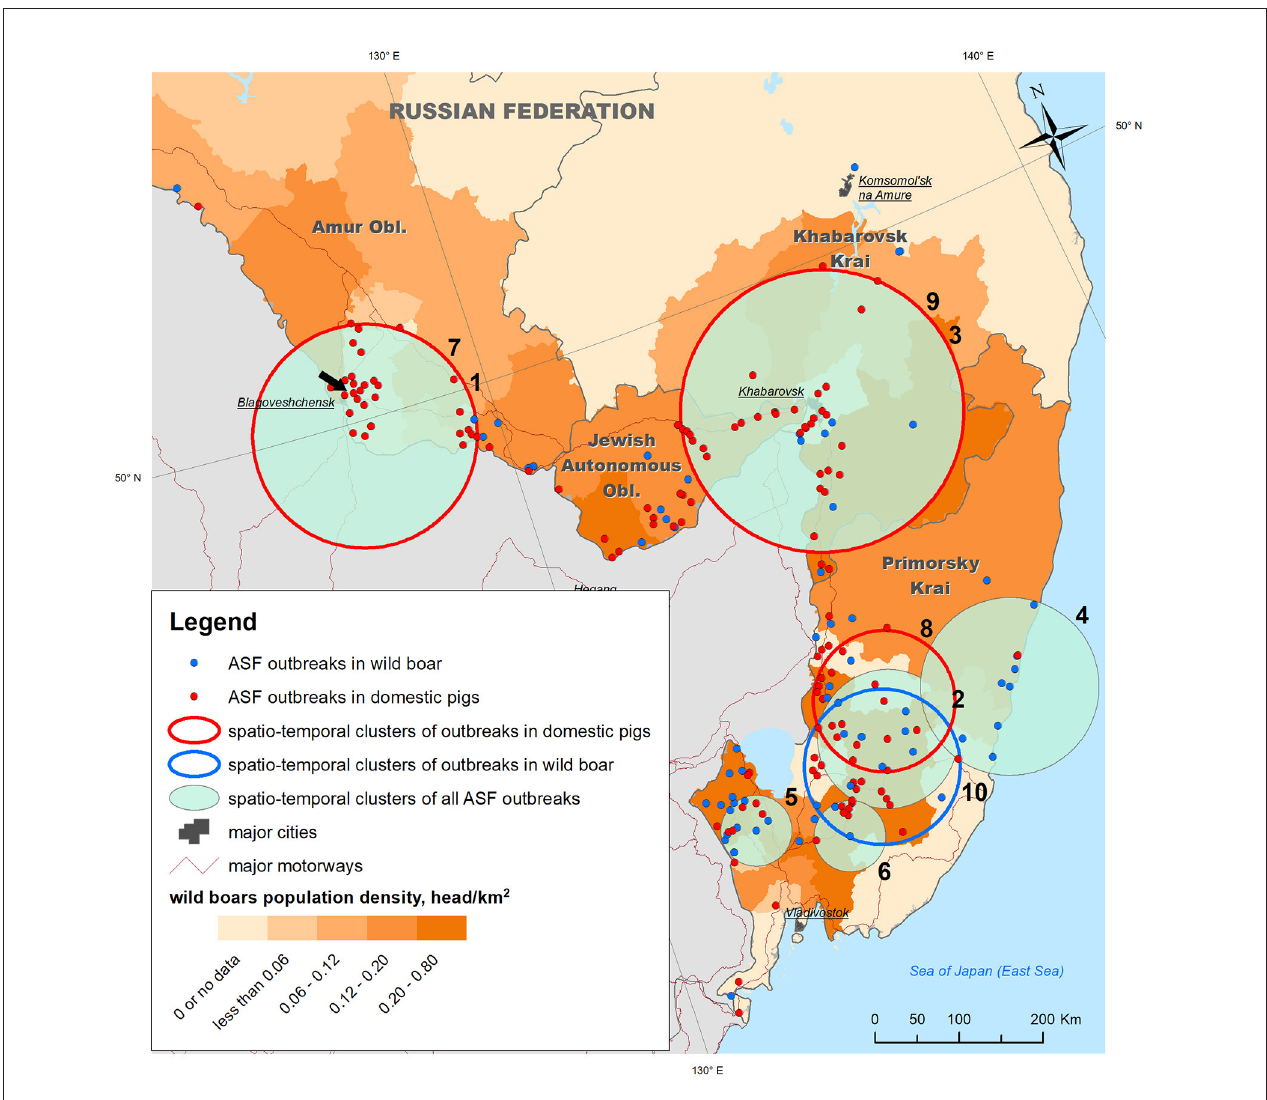
FIGURE 2 | ASF outbreaks (OIE, 2019–2020) and revealed spatio-temporal clusters of outbreaks plotted against wild boar density in the Far East regions of Russia. The black arrow points to the outbreak from which the biological material for ASFV phylogenetic analysis was sampled.